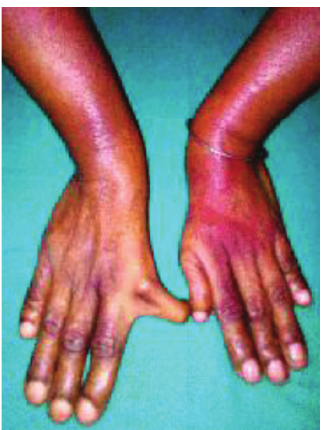
Figure 3: Absent first metacarpal bone of the left hand, underdevel- oped distal phalanges of thumb and the little finger of both